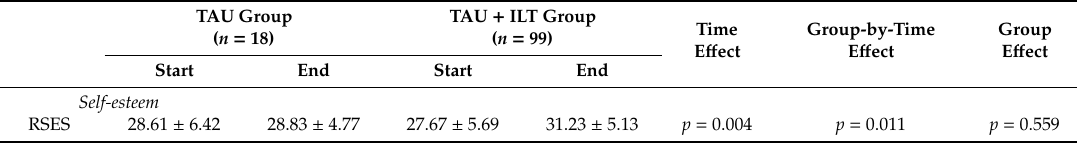
Table 4. Scores on the Rosenberg Self-esteem Scale (RSES) at the start and completion of the day hospital treatment by group.